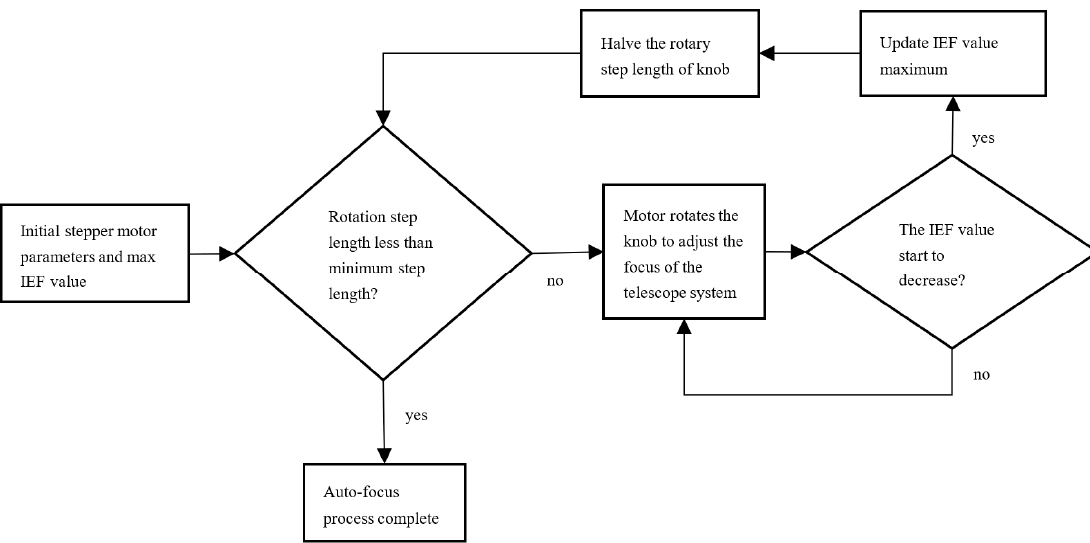
Figure 2. Auto-focus search process. IEF, image estimation function.